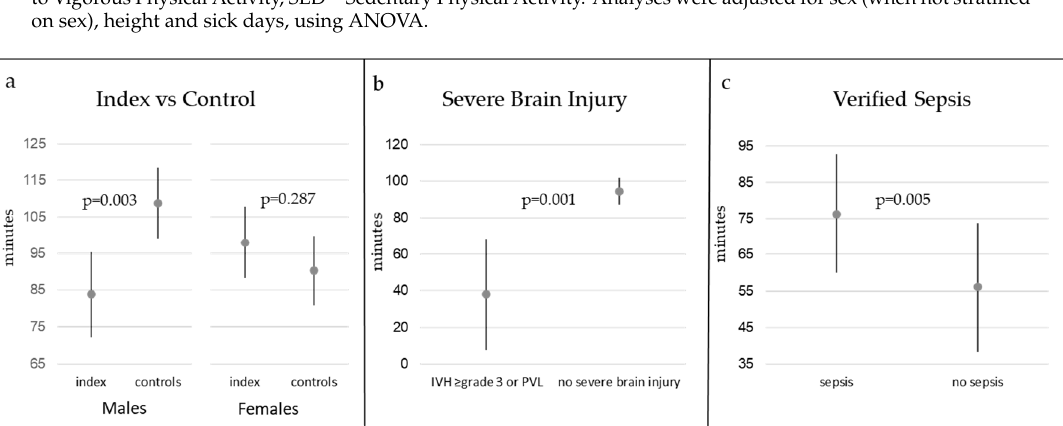
Figure 2. Average time in MVPA per day. ( a ) Comparison of average time spent in MVPA in index children and control children, stratified by sex. Error bars showing 95% confidence interval. ( b ) Comparison of time spent in MVPA between extremely preterm children with and without severe neonatal brain injury, error bars showing 95% confidence interval. ( c ) Comparison of time spent in MVPA between extremely preterm children with and without neonatal blood-culture verified sepsis. Error bars showing 95% confidence interval.